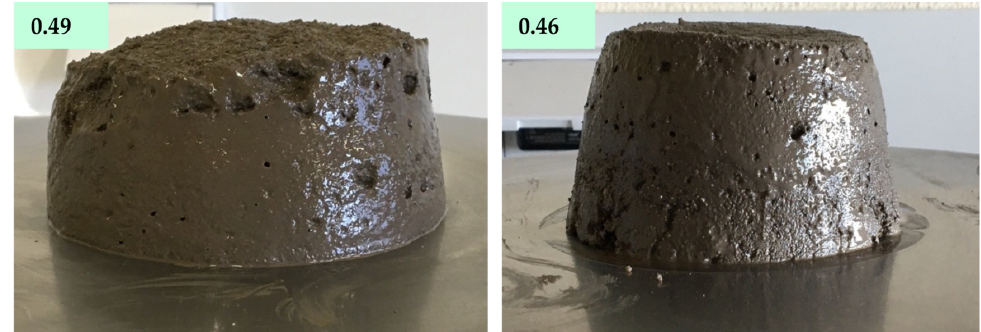
Figure 6. Appearance of MCA50 prepared with a W/B ratio of 0.49 and 0.46 after the flow table